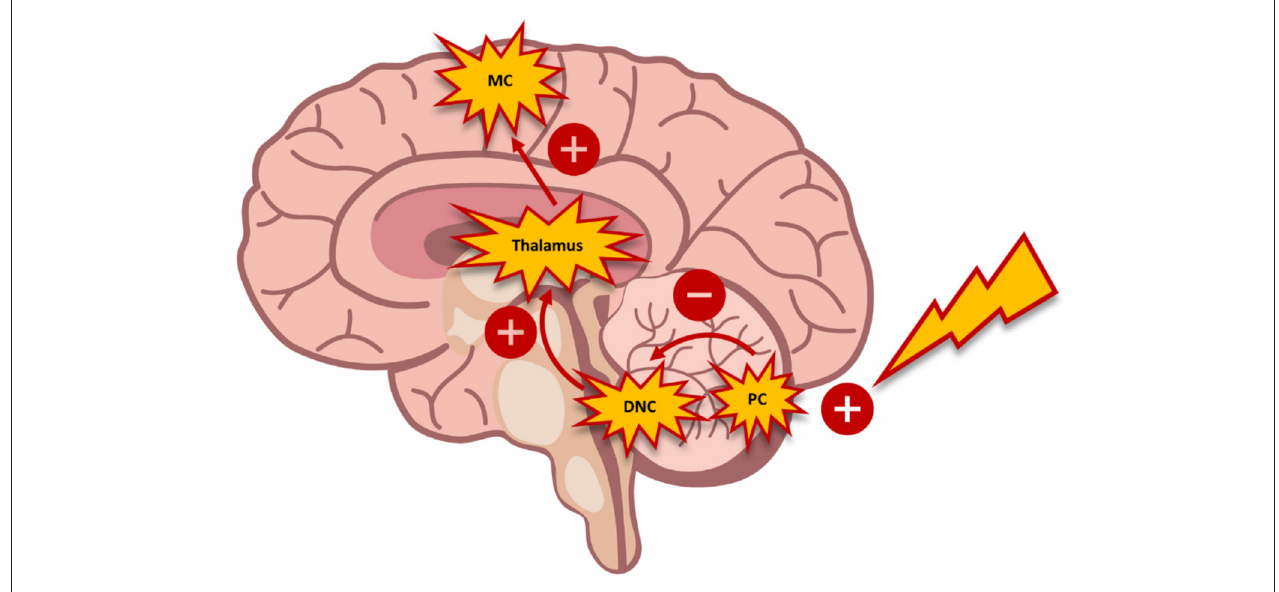
FIGURE 2 | Schematic diagram demonstrating the interaction between the cerebellum and the motor cortex. The activation of Purkinje cells ( PC ) with inhibitory connections suppresses exiting stimuli from the deep cerebellar nuclei ( DCN ) and the ventrolateral nucleus of the thalamus toward the motor cortex ( MC ). The inhibition of this circuit triggers changes in motor control, which can be measured through transcranial magnetic stimulation.